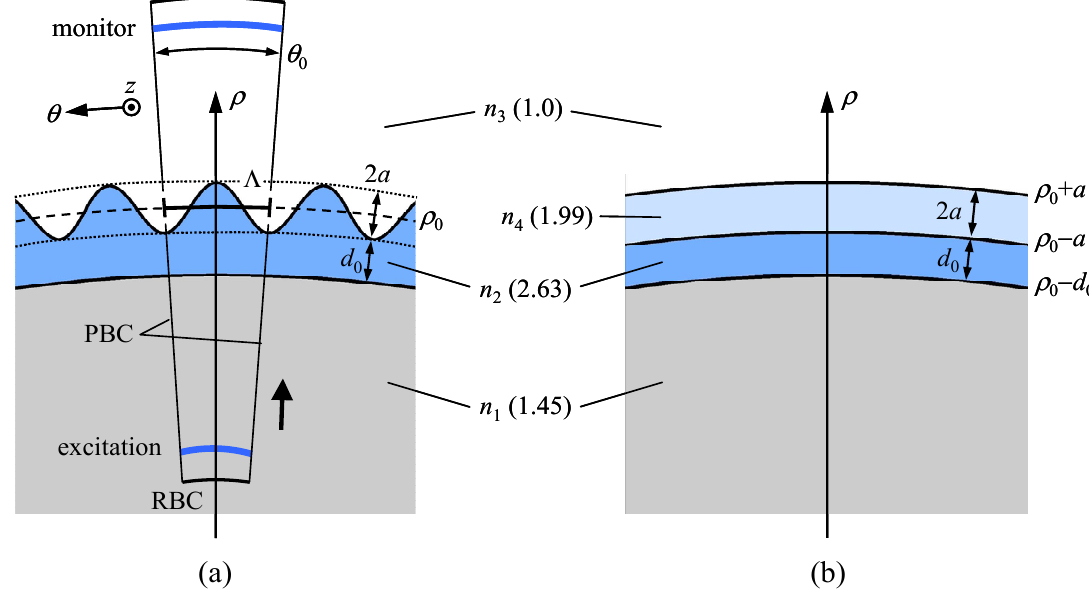
Figure 2. Detail of the sample structures. ( a ) Curved resonant grating (proposed structure). ρ , 2 a and d are the average radial position, depth and base thickness of the grating, 0 0 respectively. The region surrounded by a solid line indicates the computational domain for FDTD. PBC and RBC stand for Periodic and Radiation Boundary Conditions, respectively; ( b ) Reference curved slab structure. The grating region is replaced by an average refractive index